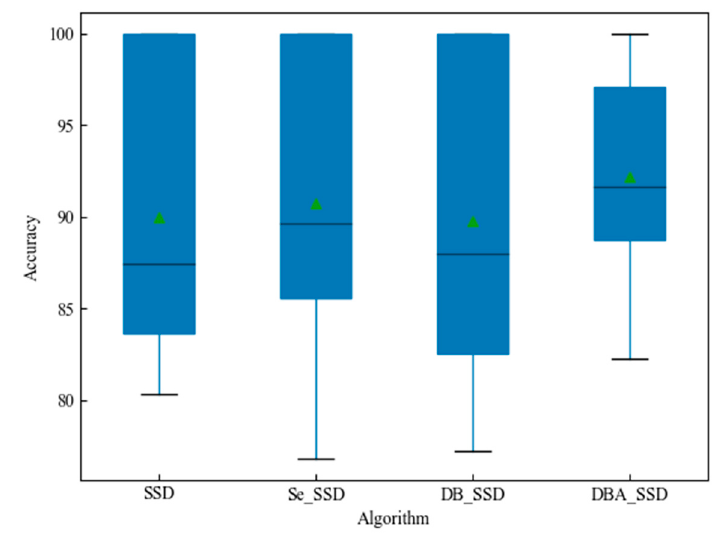
Figure 12. Box diagram of SSD and its improvement algorithm.